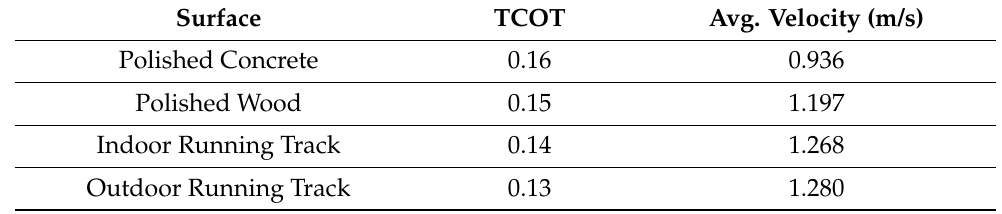
Table 2. Cost of Transport and velocities on different surfaces.